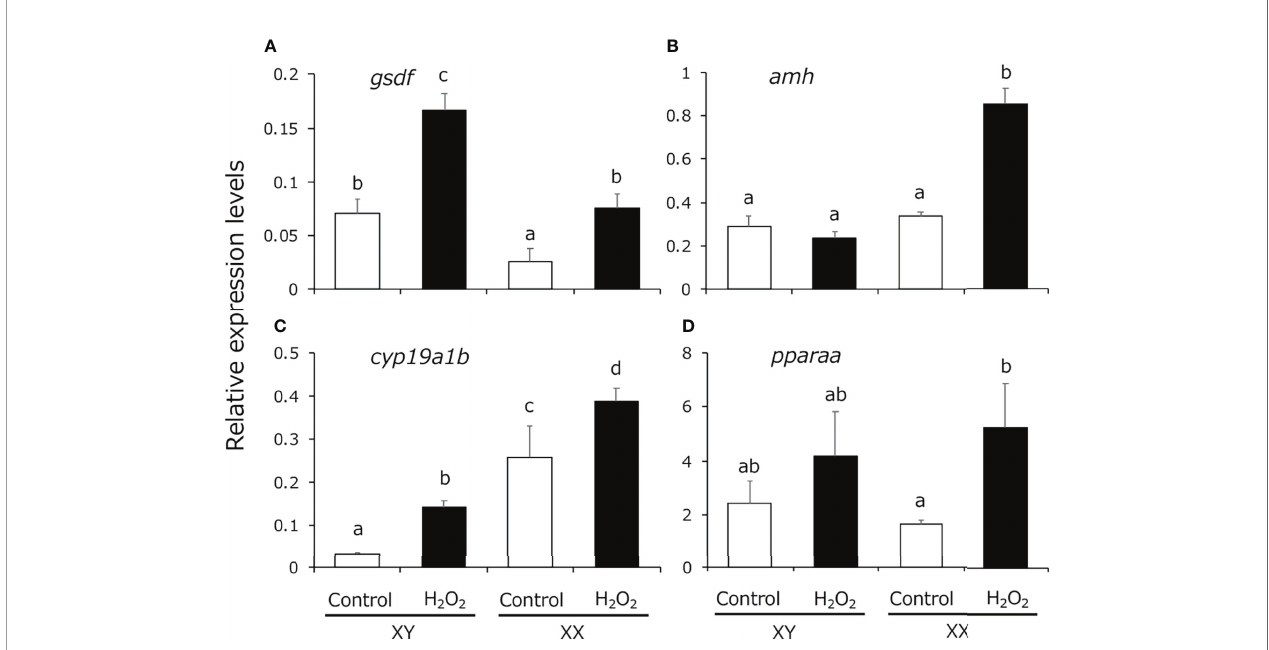
FIGURE 3 | Quantitative real-time PCR analysis of the expression of (A) gsdf , (B) amh , (C) cyp19a1b and (D) pparaa in the gonadal region of controls (white box) and H 2 O 2 -treated medaka (black box) at 5 dph. Relative expression levels of the target genes were normalized to that of ef1 a . Vertical bar: mean ± standard error of quadruplicate samples; a, b, c, d, and ab: signi fi cant difference (p < 0.05).